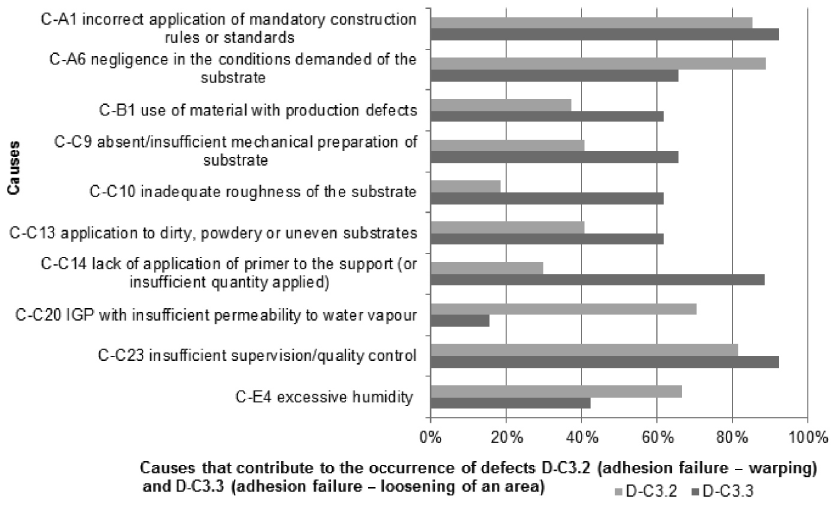
Fig. 10. Causes that contribute to the occurrence of defects D-C3.2 (adhesion failure – warping) and D-C3.3 (adhesion failure – loosening of an area)